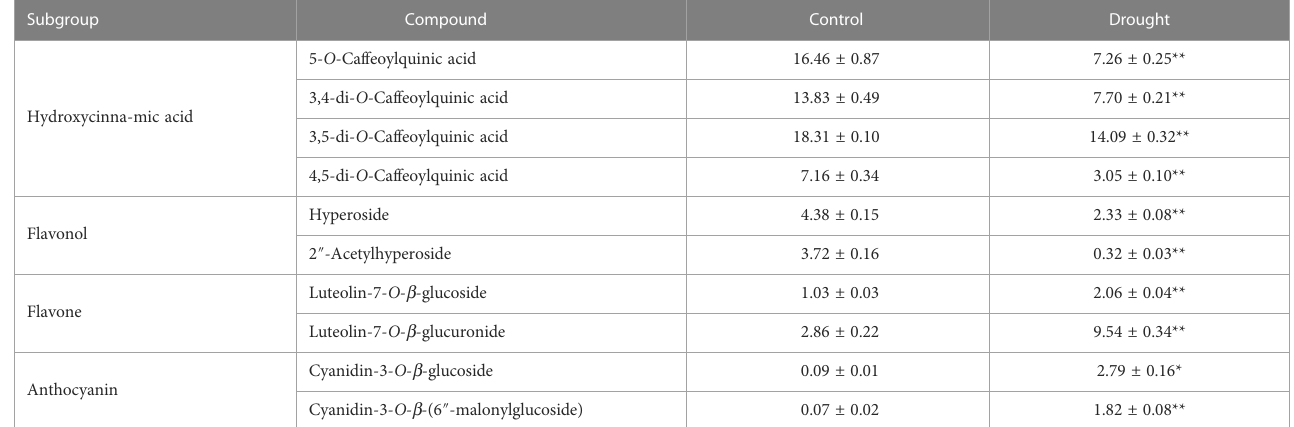
TABLE 2 Contents of phenolic compounds in L. fi scheri under drought stress (mg/g dry weight). Subgroup